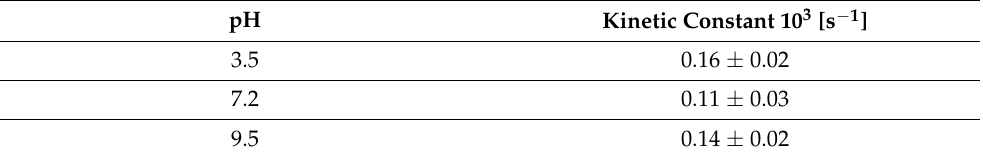
Table 4. Kinetic constant for the degradation of 2,4-D related to TiO 2 -rGO solar in function of